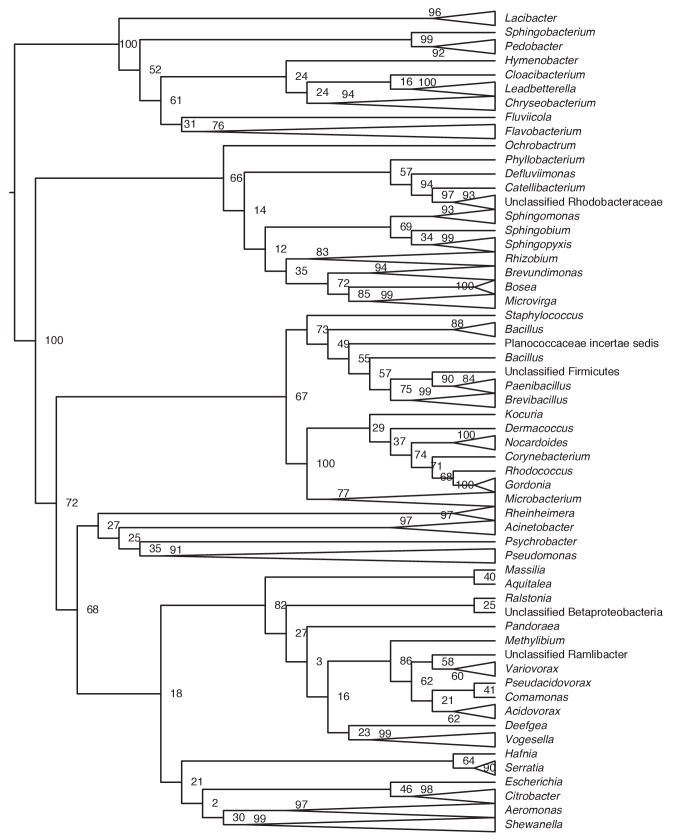
Phylogenetic tree of bacteria cultivated from the skin of toxic rough-skinned newts.Evolutionary relationships were determined by aligning newt bacterial 16S rRNA gene sequences to the SILVA Ribosomal RNA database (Quast et al., 2013) using mothur v1.40.3 (Schloss et al., 2009). Trees were constructed using randomized axelerated maximum likelihood (RAxML) with 1000 bootstrap replicates (Stamatakis, 2014) in Geneious v11.0.5 (Kearse et al., 2012). Clades with multiple bacterial isolates are represented with triangles. Bootstrap support is shown on each node.